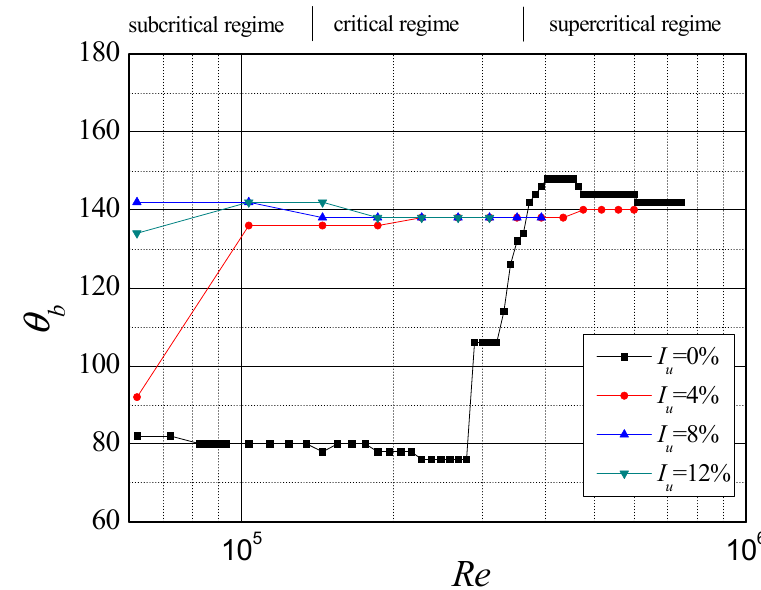
θ b in the turbulent flow. Appl. Sci. 2019 , 9 , x FOR PEER REVIEW